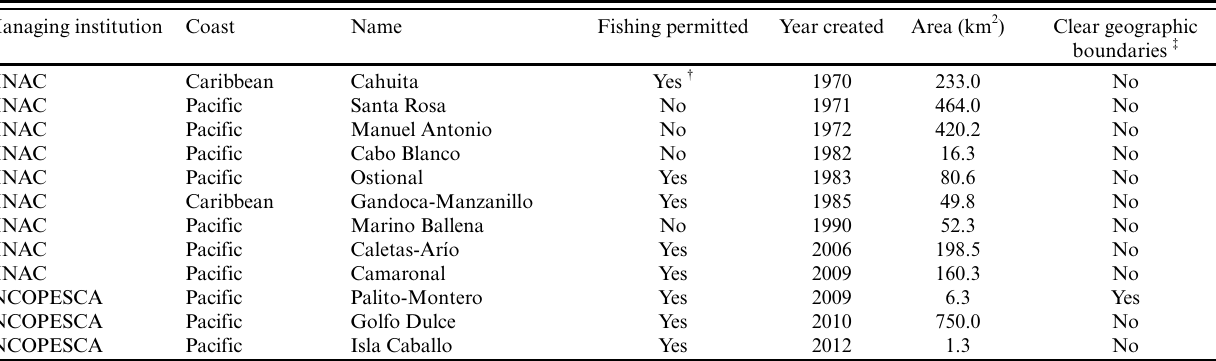
Table 1 . Marine protected areas (MPAs) included in the study and key characteristics. Caletas-Arío and Camaronal were considered as one MPA, as explained in the